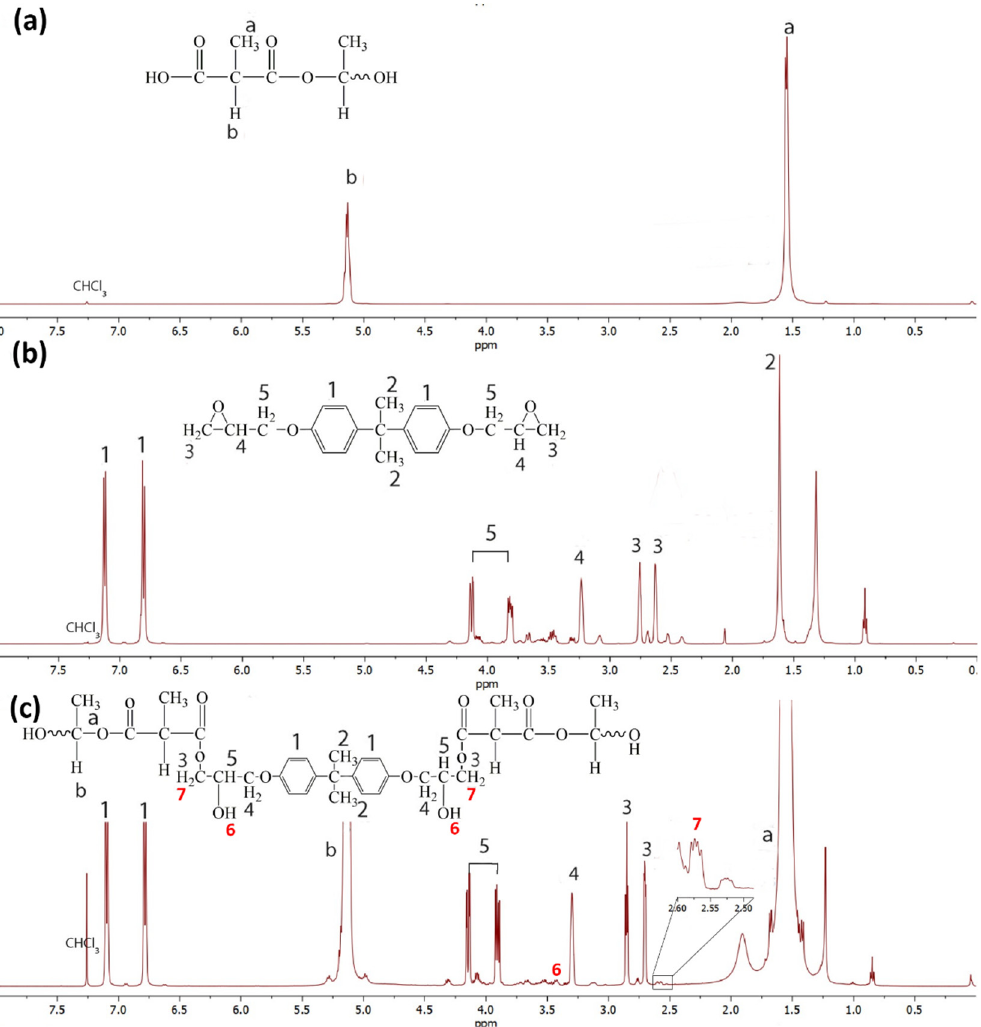
Figure 6. 1 H NMR spectra and structures of ( a ) neat PLA, ( b ) epoxy, and ( c ) the PLA/epoxy20 blend.